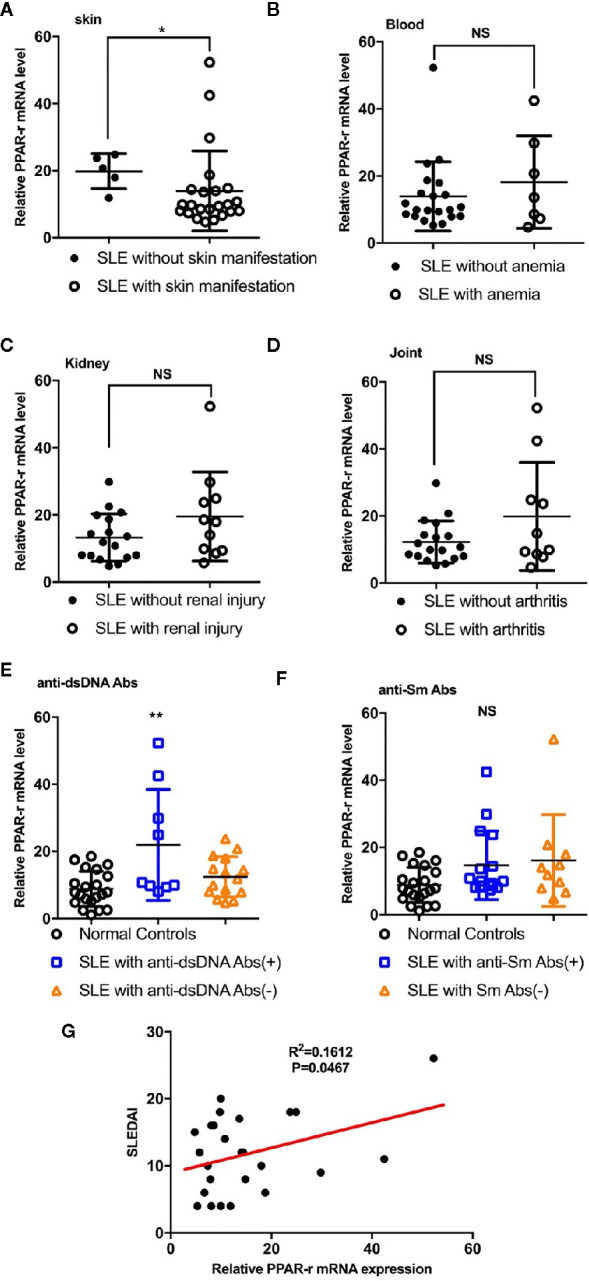
Correlations between PPAR-γ levels and phenotypes, autoantibody levels and SLEDAI. (A) PPAR-γ expression in the SLE patients without skin manifestations was higher than that in the SLE patients with skin manifestations (n = 23). (B–D) PPAR-γ expression in the SLE patients with involvement of the blood system (B) (n = 7), kidney (C) (n = 11), and arthrosis (D) (n = 10) showed no significant differences compared with that in their control groups. (E) PPAR-γ expression in the anti-dsDNA Abs-positive SLE (n = 9) patients was higher than that in the anti-dsDNA Abs-negative SLE patients (n = 15). (F) The expression of PPAR-γ in the SLE patients was not affected by anti-Sm Abs (n = 16 for anti-Sm Abs positive patients and n = 10 for anti-Sm Abs negative patients). (G) The correlation between PPAR-γ expression and SLEDAI (n = 25). The RT-PCR results were normalized to GAPDH. Each symbol represents an individual healthy control or patient (ns: no significance, *p < 0.05, **p < 0.01).